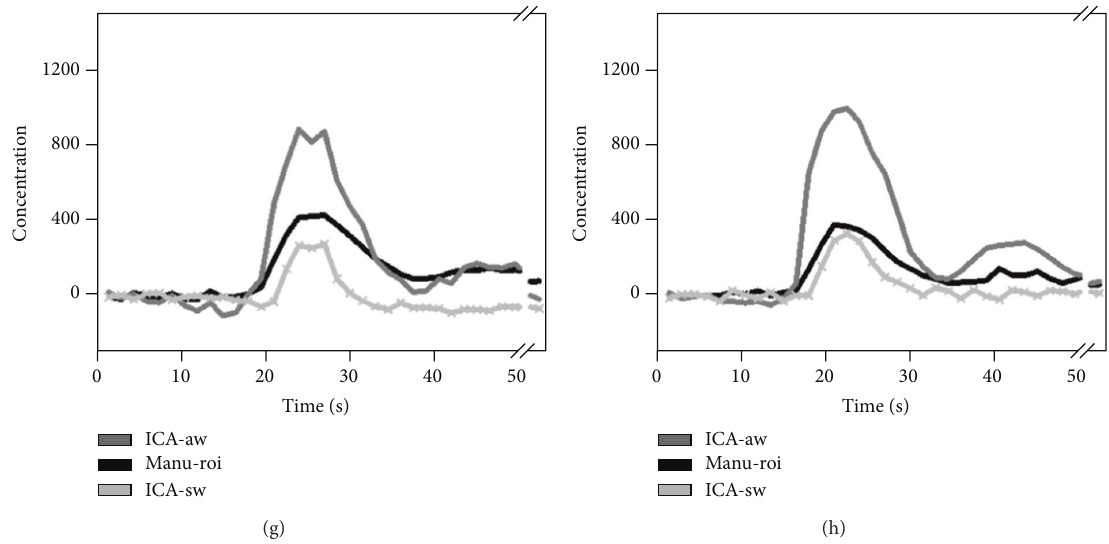
Figure 4: Different AIFs were determined for eight subjects in (a)–(h). (1) The artery with weighted-ICA (solid dark gray line); (2) the average with manual ROI (solid black line); and (3) the surrounding tissue with weighted-ICA (solid light gray line). This figure also shows the